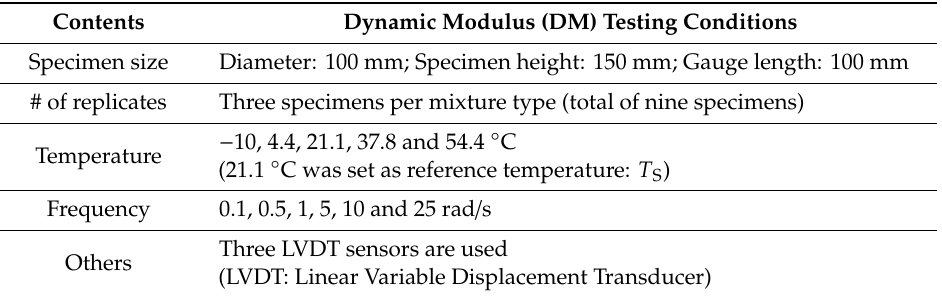
Table 2. Dynamic modulus-testing